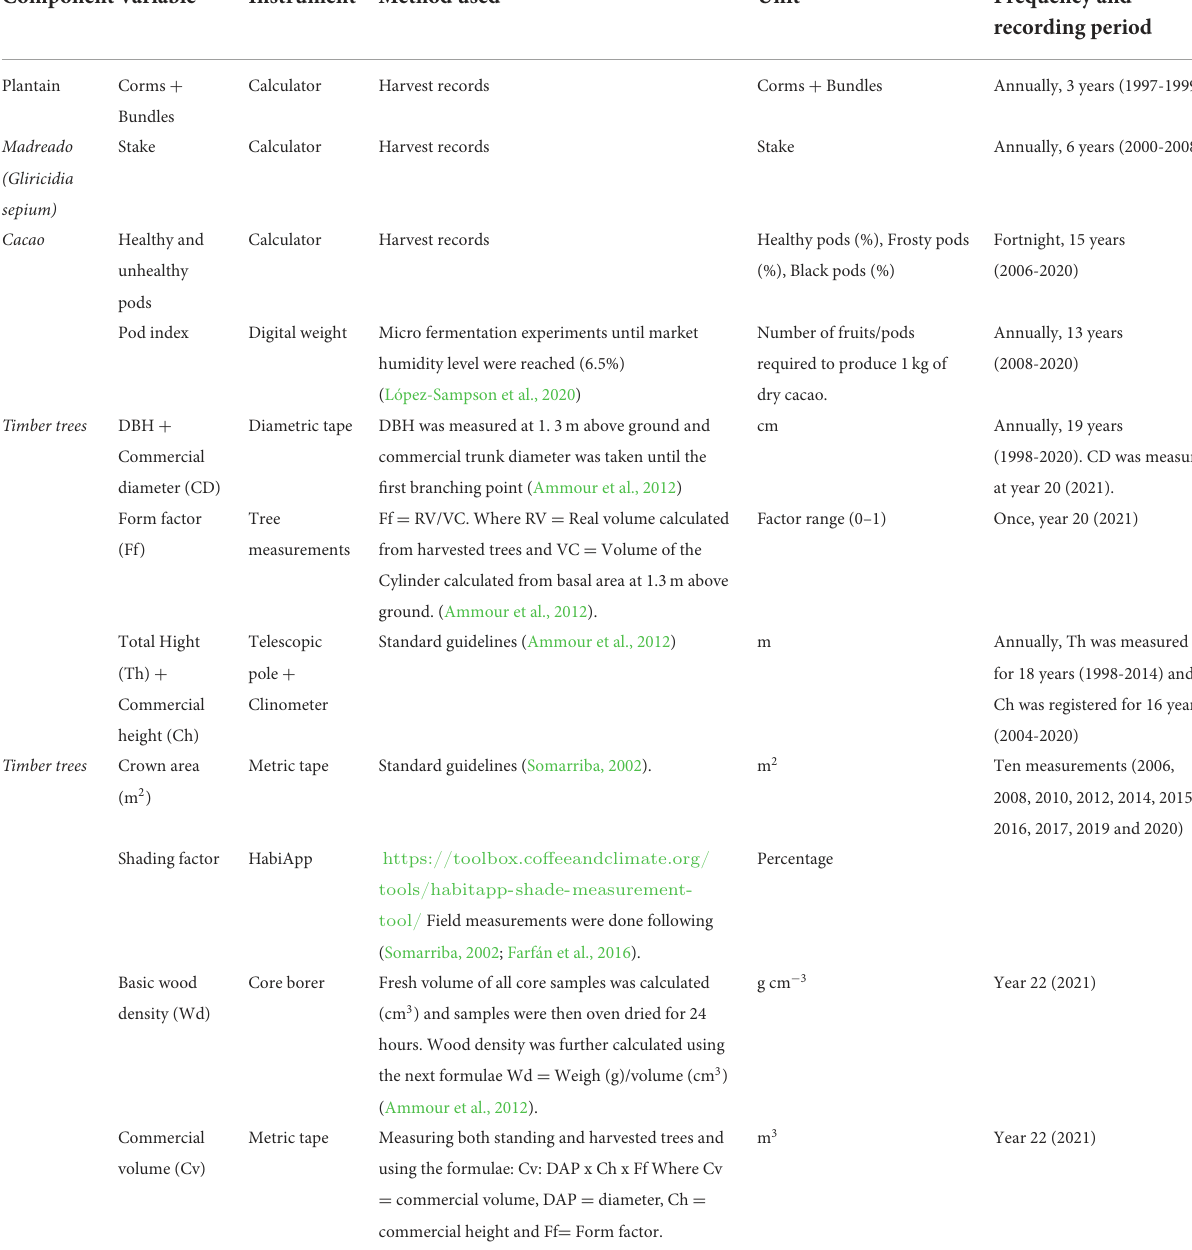
TABLE 2 Summary of measurements and methods used to assess timber growth rates and cacao yields in the experimental site “CEDEC-JAS,” La Masica, Ataltida, Honduras. ComponentVariable Instrument Method